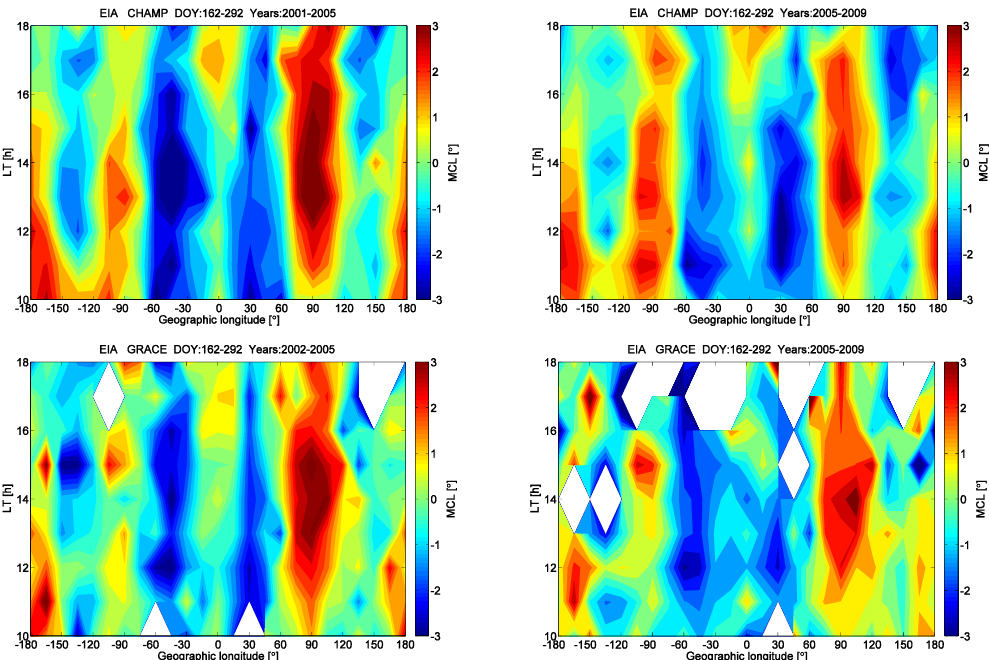
Fig. 1. The local time versus longitudinal distribution of the EIA latitude parameter MCL from CHAMP (top) and GRACE (bottom) observations during higher (left) and lower (right) solar activity years around August; data are from DOY between 162 and 292.